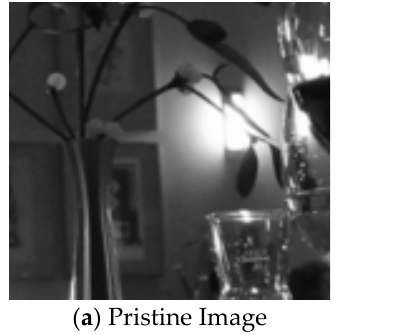
Figure 1. Pristine image and histogram.